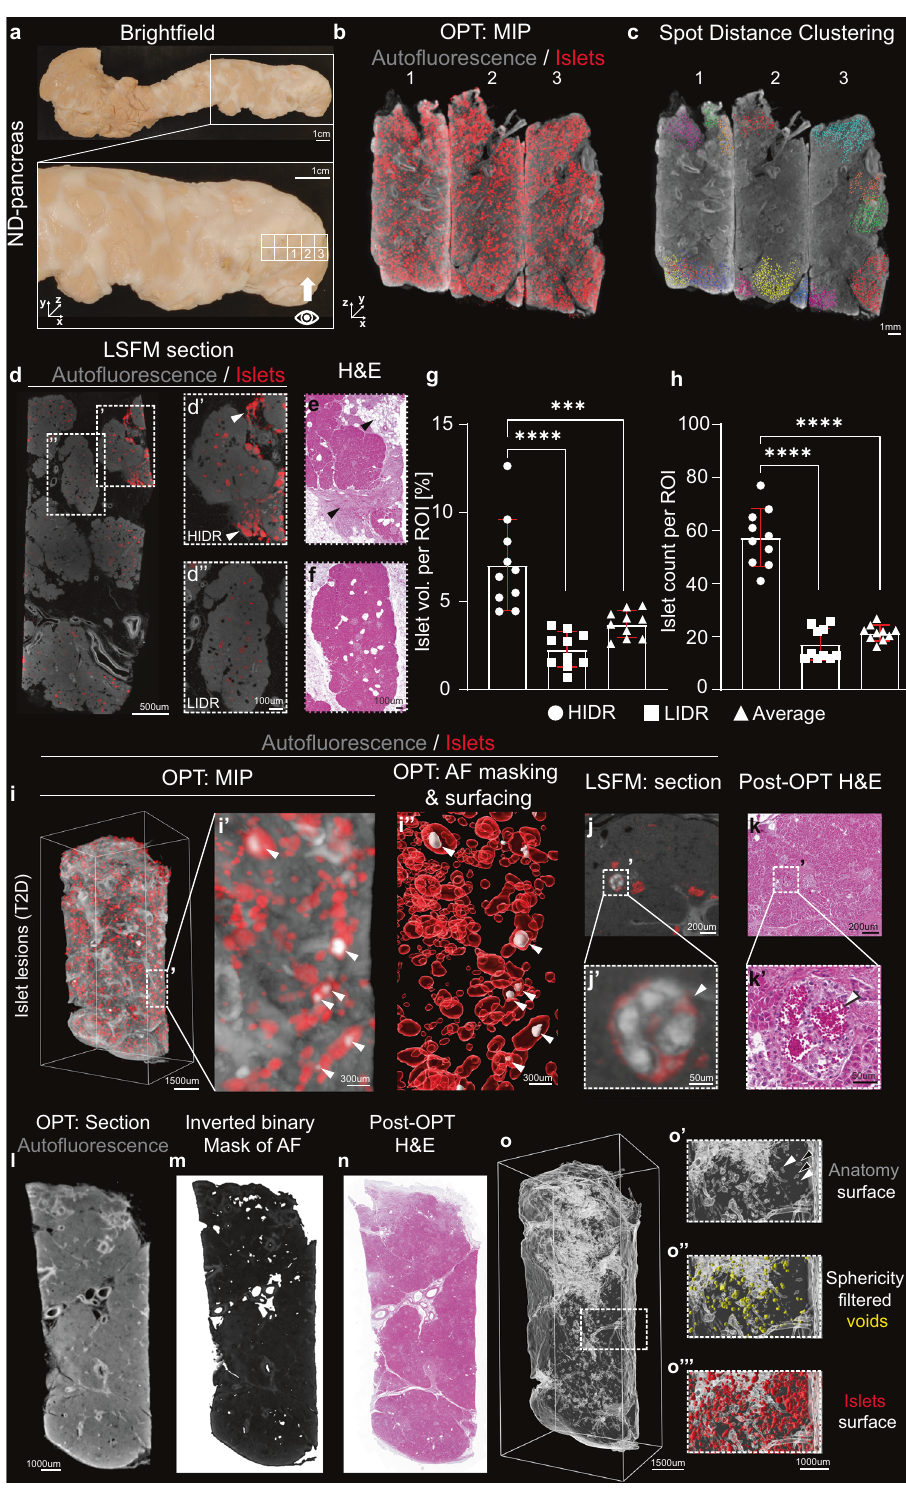
algorithm-assisted shape-category selection, various features